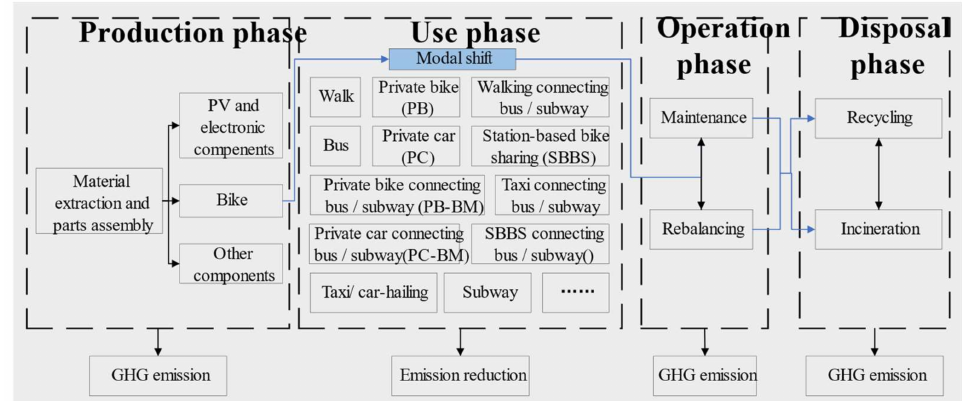
Figure 1. System boundary of the free-floating bike sharing